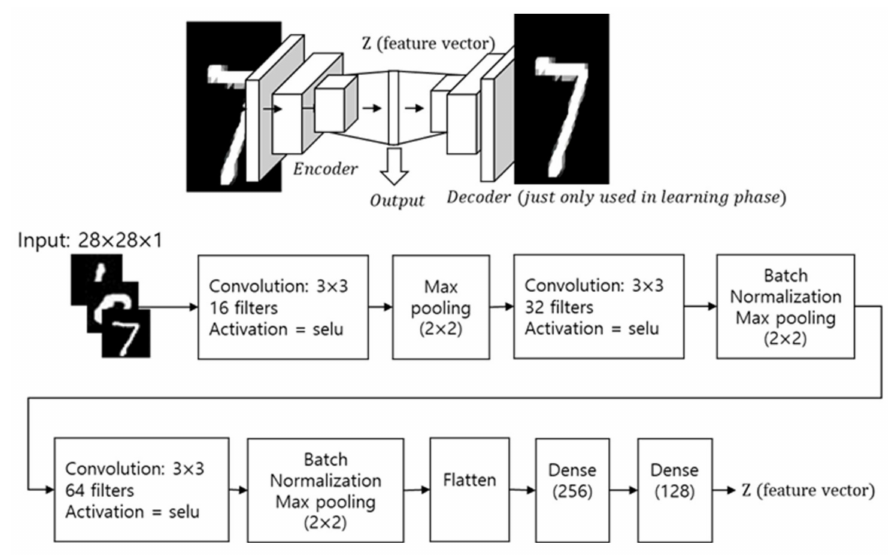
Figure 9. Feature extraction by CNN-autoencoder.